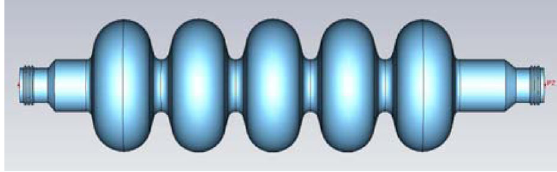
FIG. 14. MWS models for the BNL3 cavity with 22 cm di- ameter beam tubes and end tapers as presently being